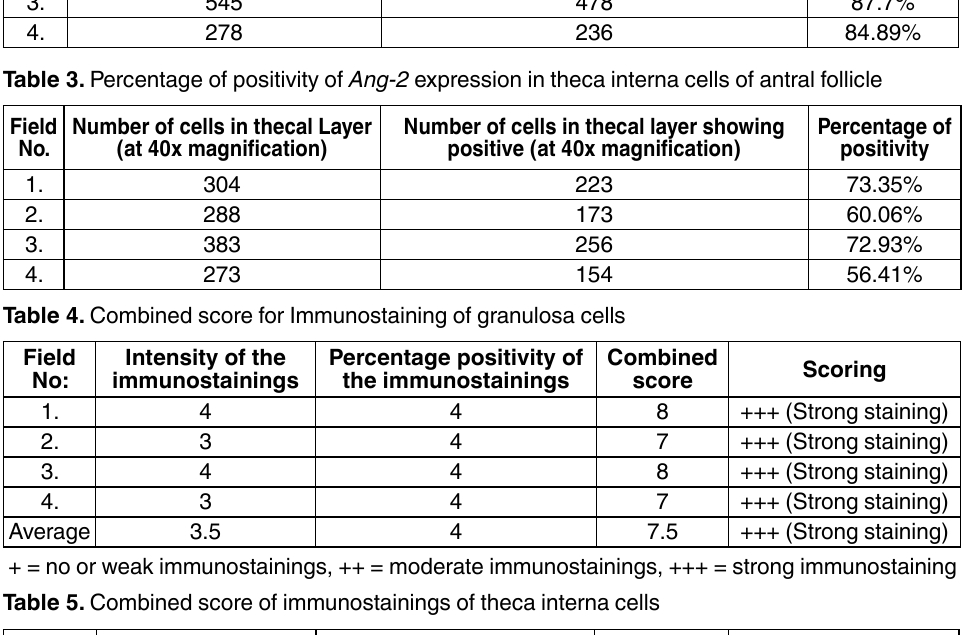
table 2. Percentage of positivity of Ang-2 expression in granulosa cells of antral follicle Field No.